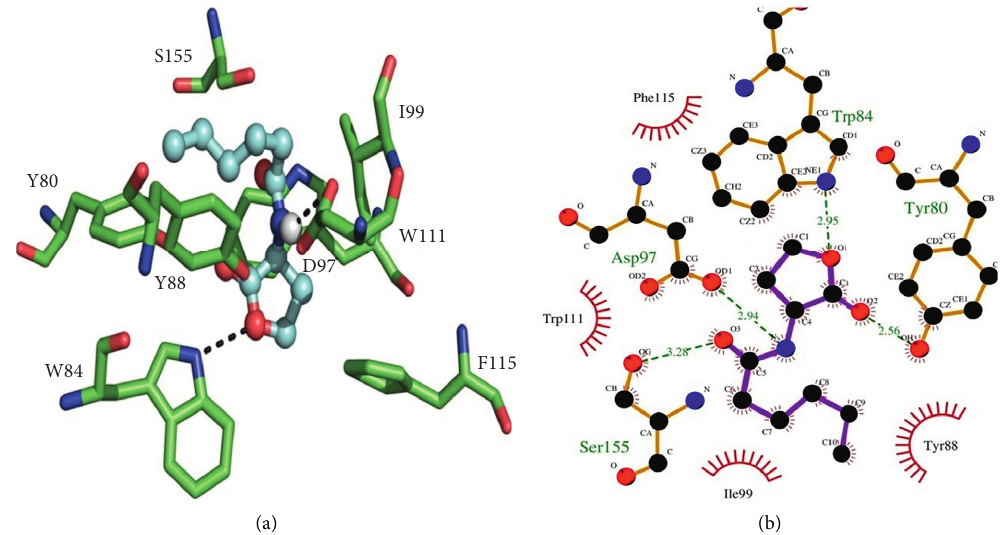
Figure 6: The interaction of N -hexanoyl homoserine lactone with CviR portrayed in 3D.